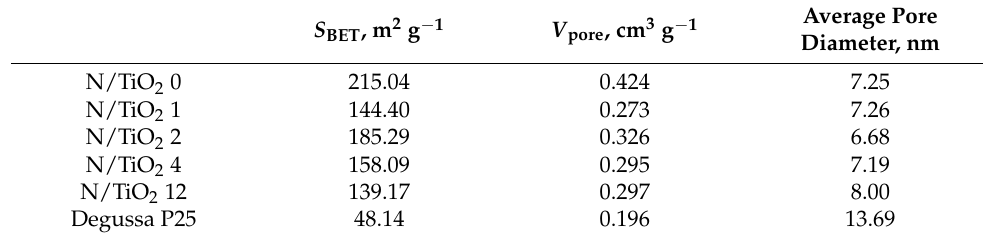
Table 3. Specific surface area, pore-volume, and pore size of N/TiO 2 materials and Degussa